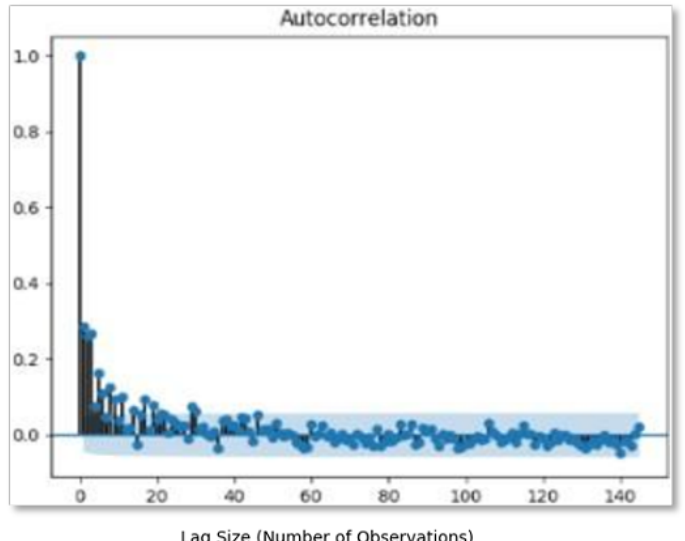
Figure 3. Autocorrelation plot for the single household data. The vertical axis shows the ACF value. The horizontal axis of the plot shows the size of the lag between the elements of the time